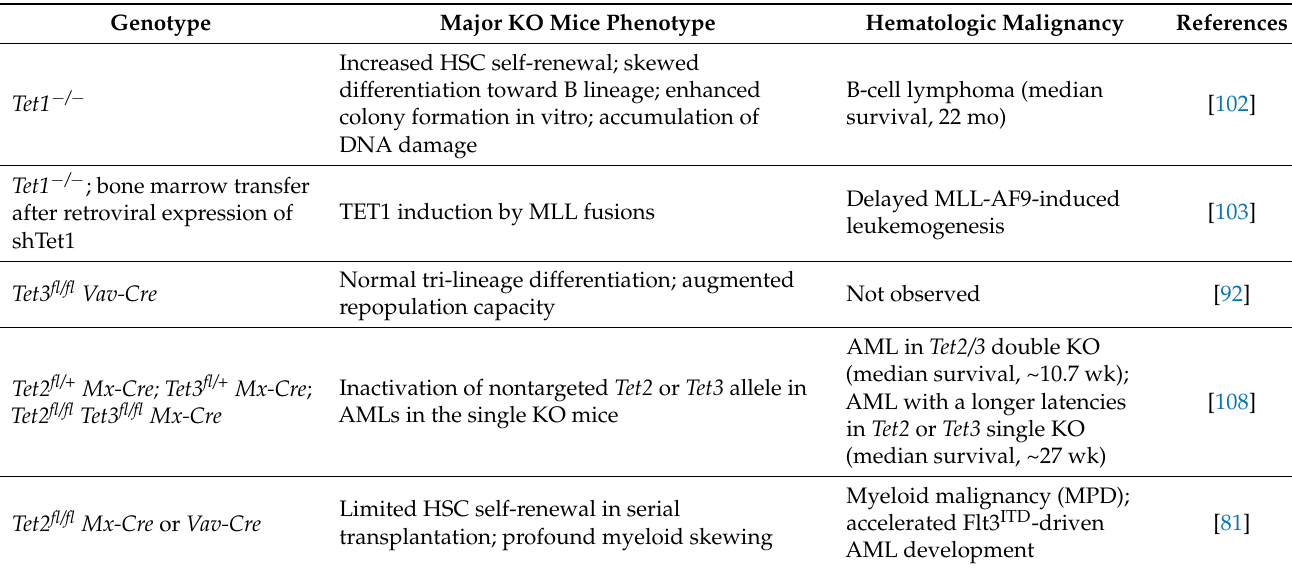
Table 2. Hematopoietic phenotypes of TET-deficient animal models. Genotype Major KO Mice